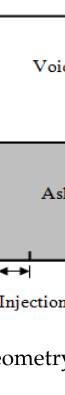
Figure 33. Schematic of an underground coal gasification cavity from field observation (redrawn from Perkins and Sahajwalla [61]).